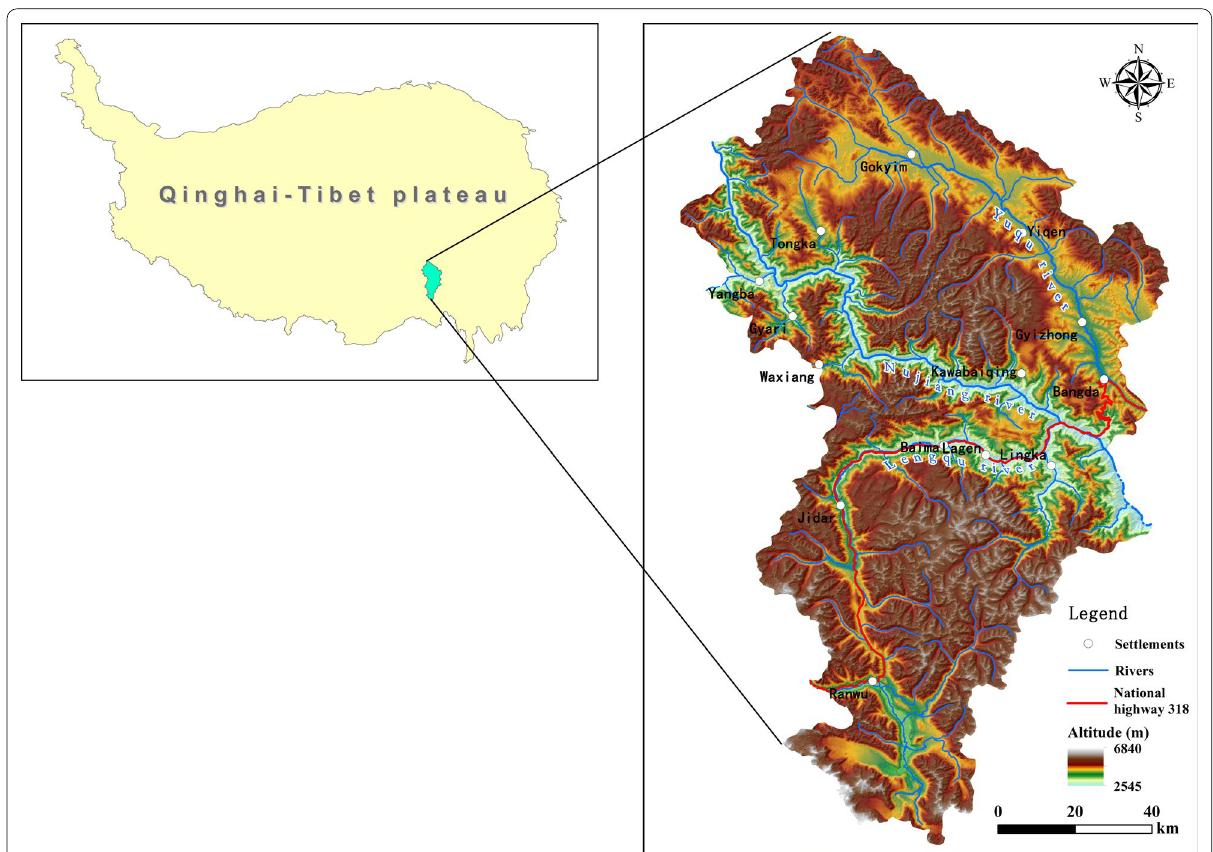
Fig. 1 The geographic location of the study